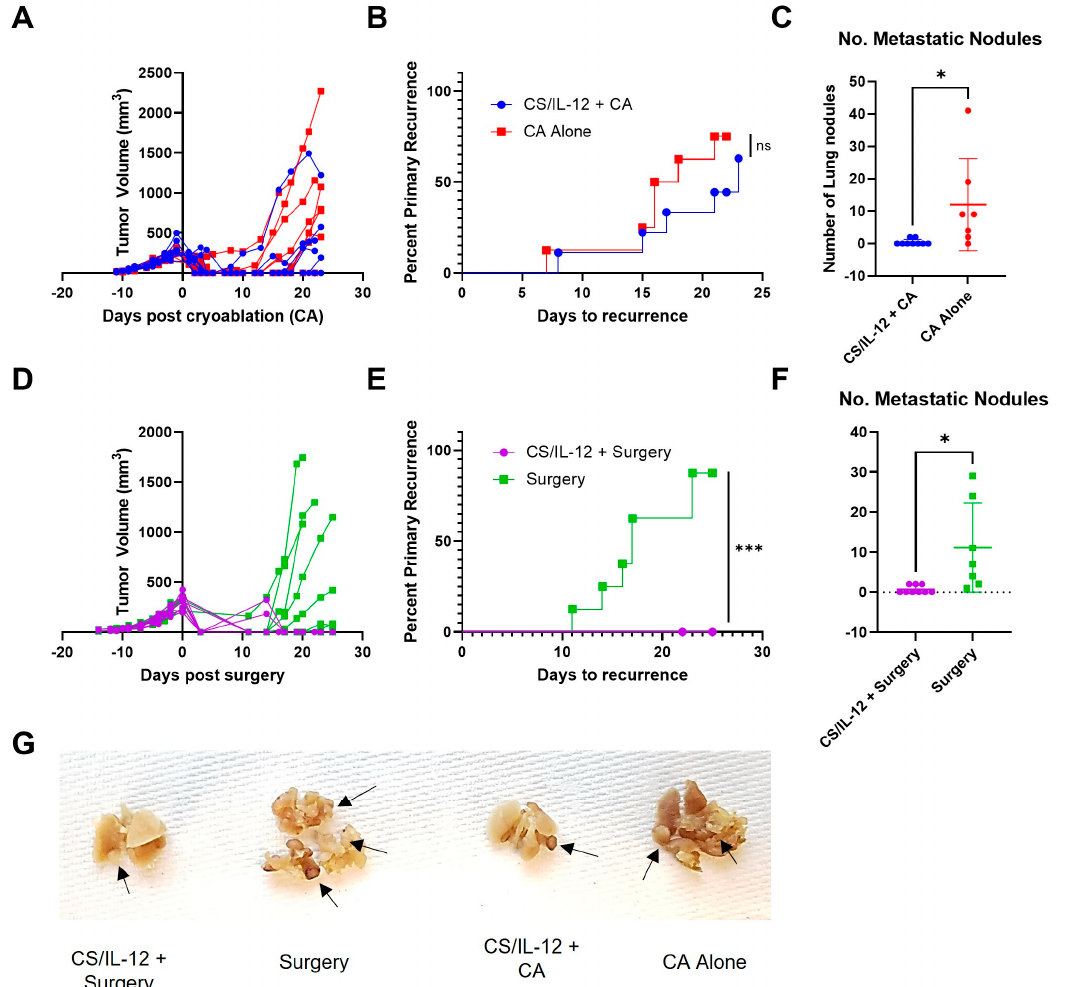
Figure 3. Addition of neoadjuvant CS/IL-12 to CA and tumor resection inhibits lung metastases. Lewis lung carcinoma (LLC1) cells were implanted subcutaneously in the right flank and treated with either CA alone (n = 9) or CA + CS/IL-12 delivered intratumorally 2 days before ablation (n = 9) ( A – C ) or tumors were resected with (n = 10) or without (n = 8) CS/IL-12 neoadjuvant ( D – F ). Tumor volume ( A , D ) was monitored and the number of days to recurrence ( B , E ) was measured as the first day post CA that a tumor mass was measurable. All mice were euthanized on either day 22 or 23 after CA and lungs were dissected in order to visualize and count metastatic nodules ( C , F ). Representative lungs from each group are shown in ( G ), where examples of metastatic nodules are indicated with an arrow. Statistical significance was calculated using the Log-rank (Mantel–Cox) test ( B , E ) and Student’s t -test ( C , F ). ns—not signi fi cant; * p < 0.05; *** p < 0.001;.